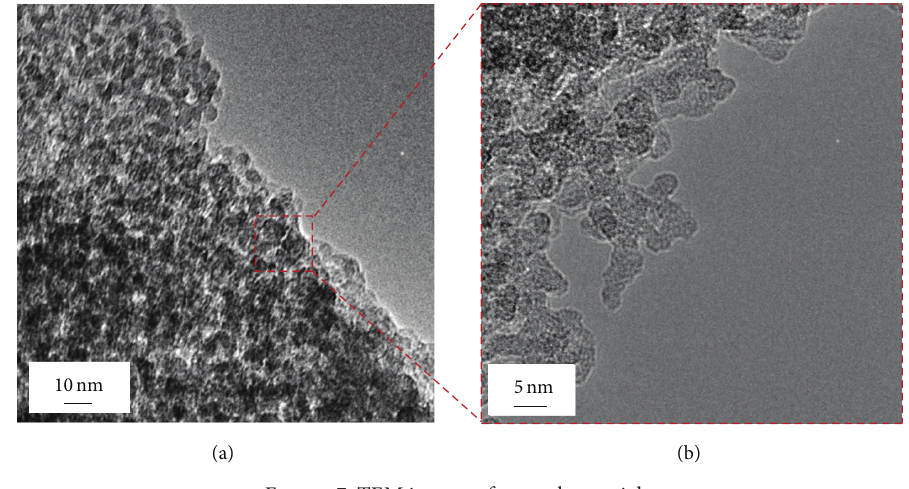
Figure 7: TEM images of aerogel